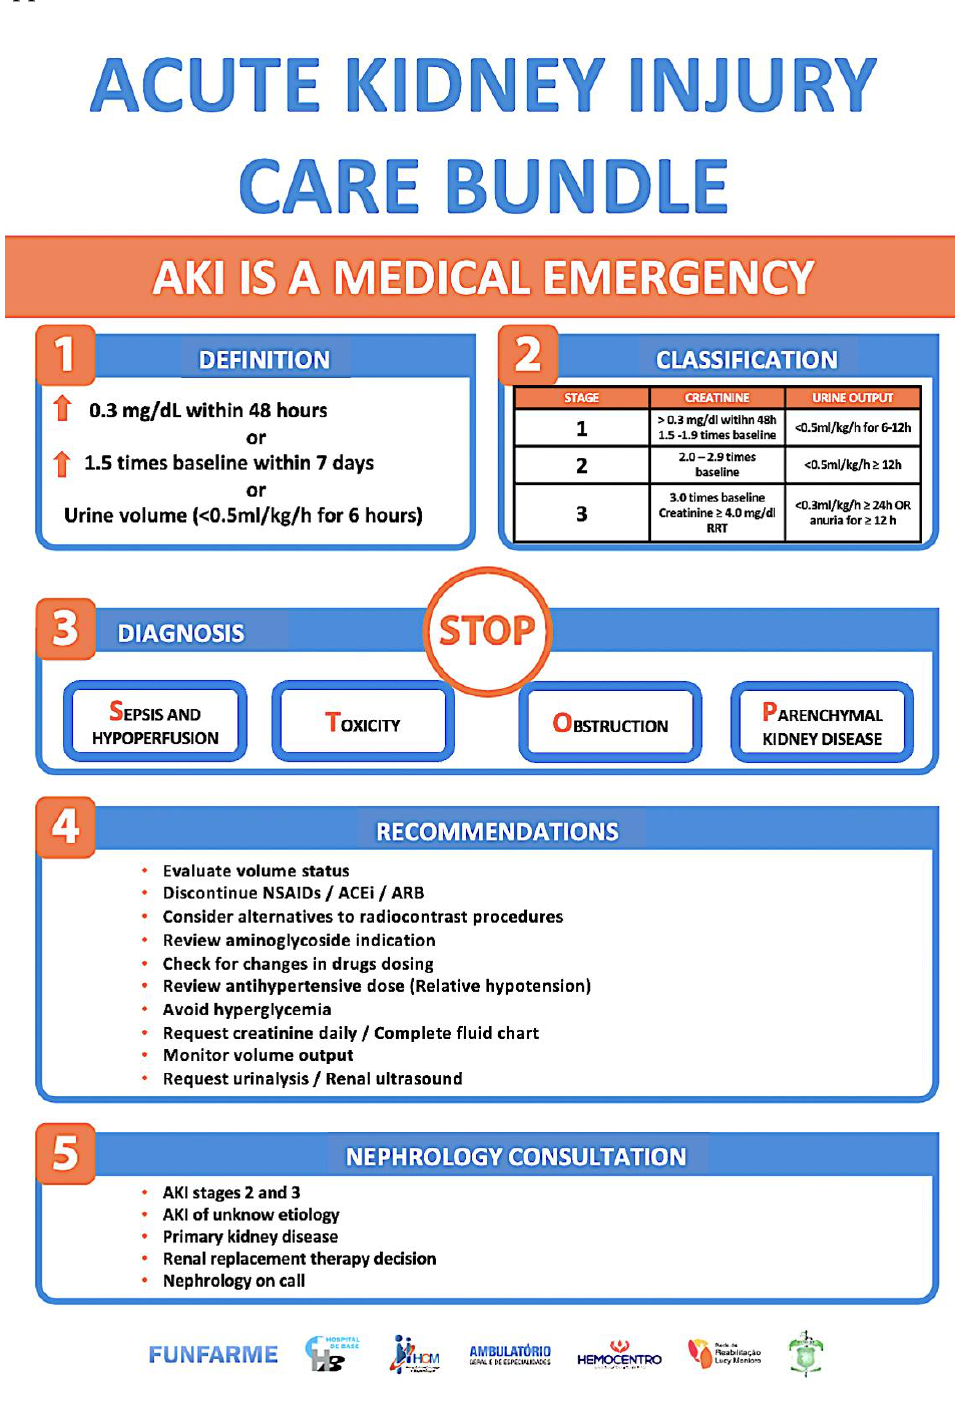
Figure A2. Suggested AKI care bundle